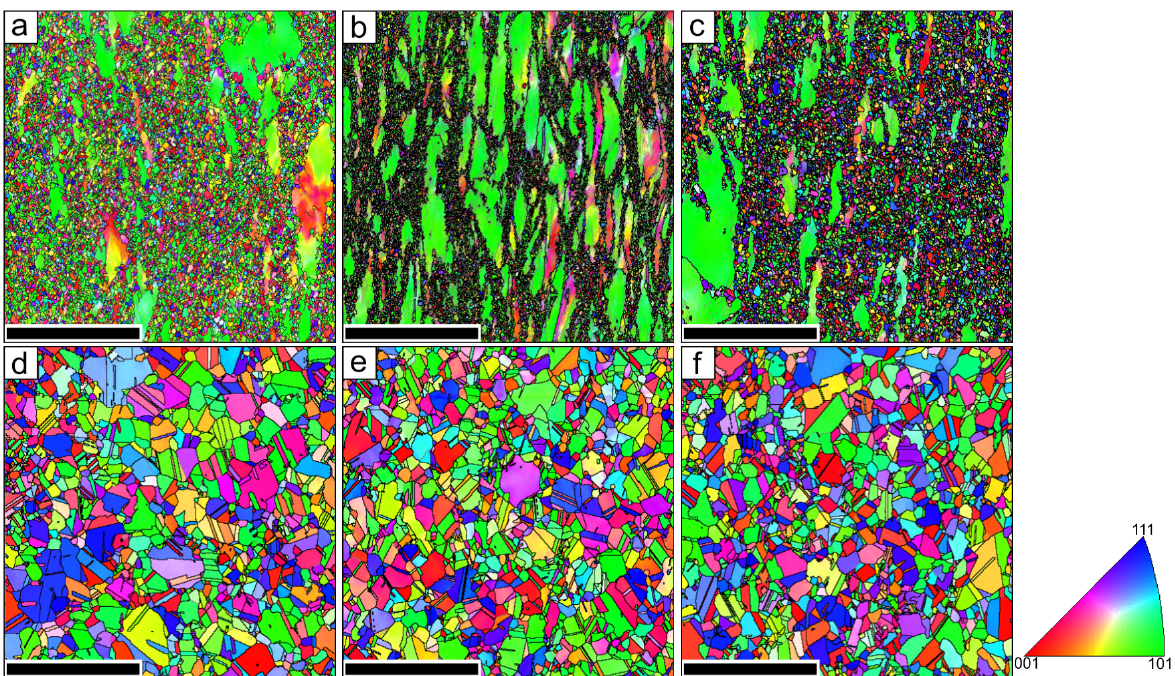
Figure 7. IPF maps for all samples deformed at 1080 ◦ C, where black lines show HAGB > 10 ◦ and grey lines LAGB < 10 ◦ . ( a – c ) Q samples deformed at strain rates of ( a ) 0.05 s − 1 , ( b ) 0.5 s − 1 and ( c ) 5 s − 1 , respectively. ( d – f ) H samples deformed at strain rates of ( d ) 0.05 s − 1 , ( e ) 0.5 s − 1 and ( f ) 5 s − 1 . The scale bars are 200 µ m. Deformation direction was horizontal with respect to the IPF maps.